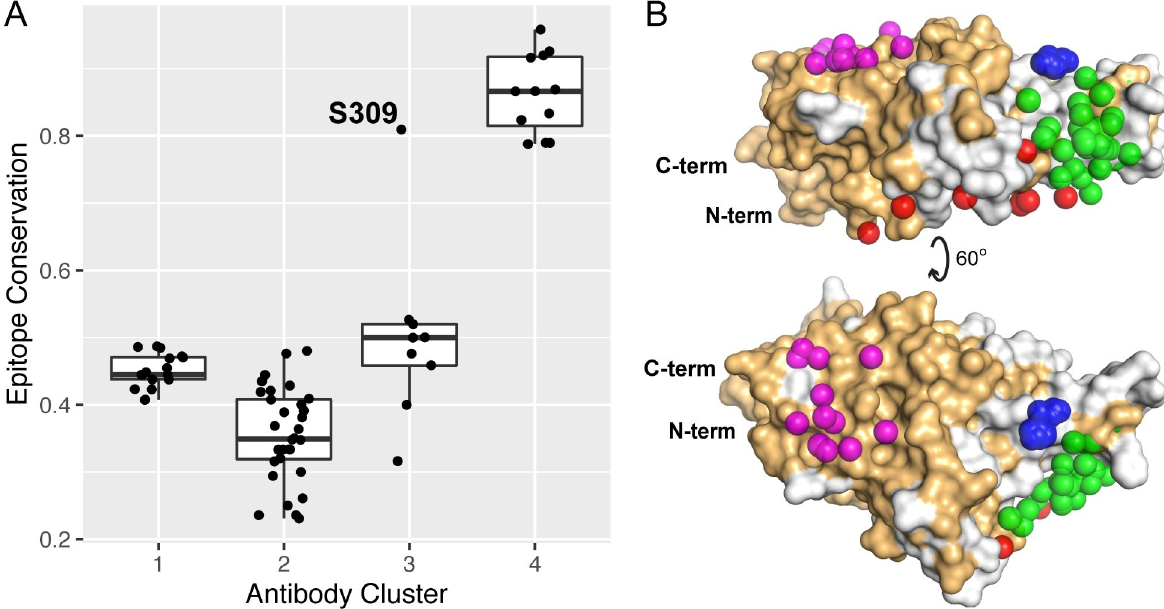
Fig 6. Epitope residue conservation in SARS-CoV-1 by antibody cluster. (A) Epitope conservation, defined as the fraction of RBD epitope residues ( < 5 Å distance to antibody) conserved between SARS-COV-1 and SARS-COV-2, was calculated for 70 antibody-RBD complex structures, and conservation values are shown as a boxplot grouped by antibody clusters, with all conservation values shown as points. The outlier point for Cluster 3 (S304 antibody) is labeled, and the total numbers of points are 17 (Cluster 1), 32 (Cluster 2), 9 (Cluster 3), and 12 (Cluster 4). (B) Conserved RBD residues are highlighted on the RBD structure, with conserved RBD residues shown as orange and non-conserved residues gray, and represented as in Fig 3A with antibody cluster paratopes as spheres.